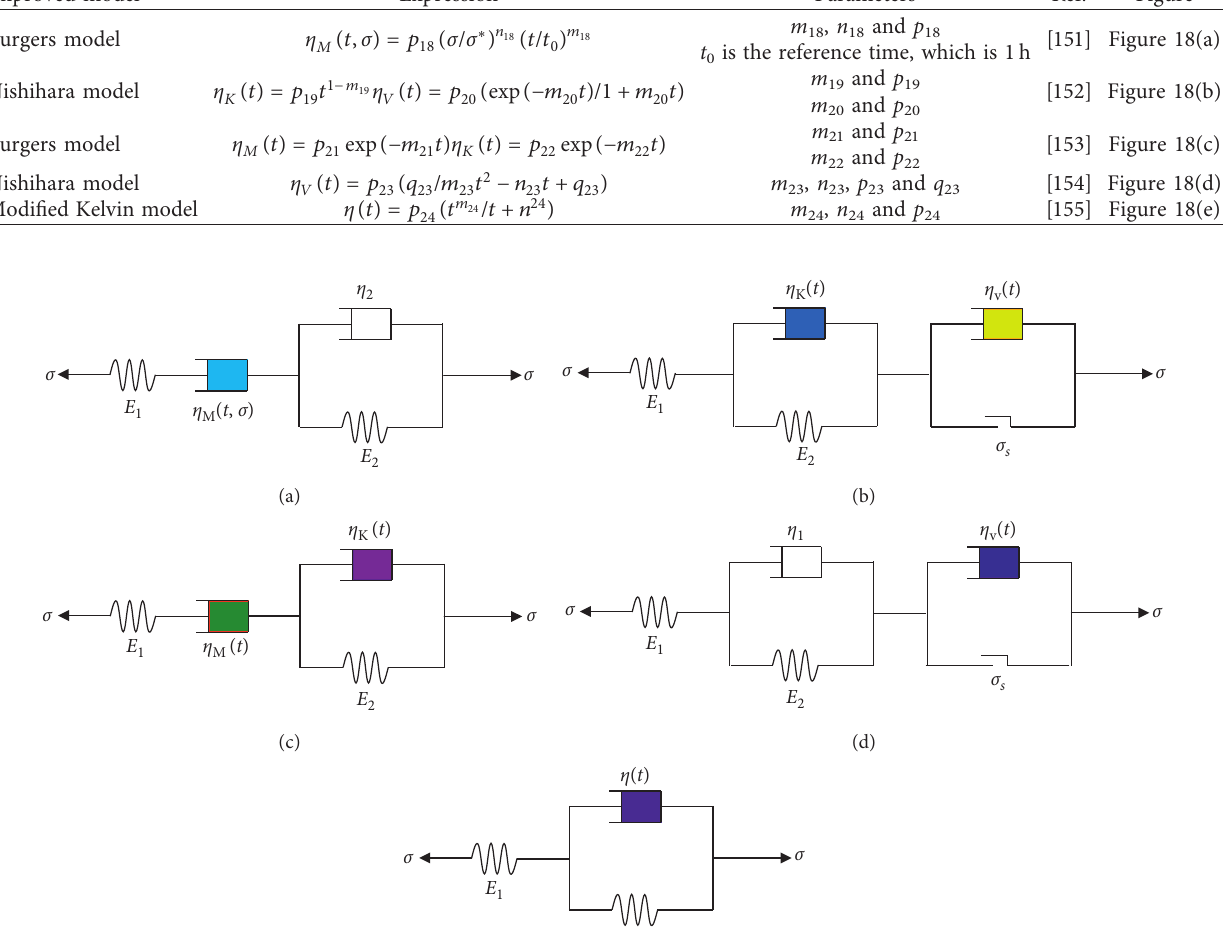
Table 3: The viscosity coefficient expressions of the nonlinear element and the corresponding modified model. Improved model Expression Parameters Ref. Burgers model